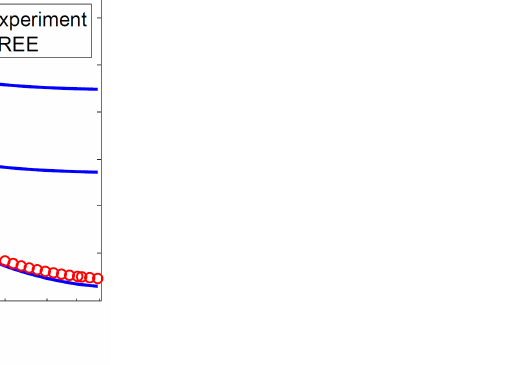
Figure 7. The changes in the reactance Δ X normalised with respect to the reactance X 0 for sample made of brass and copper.